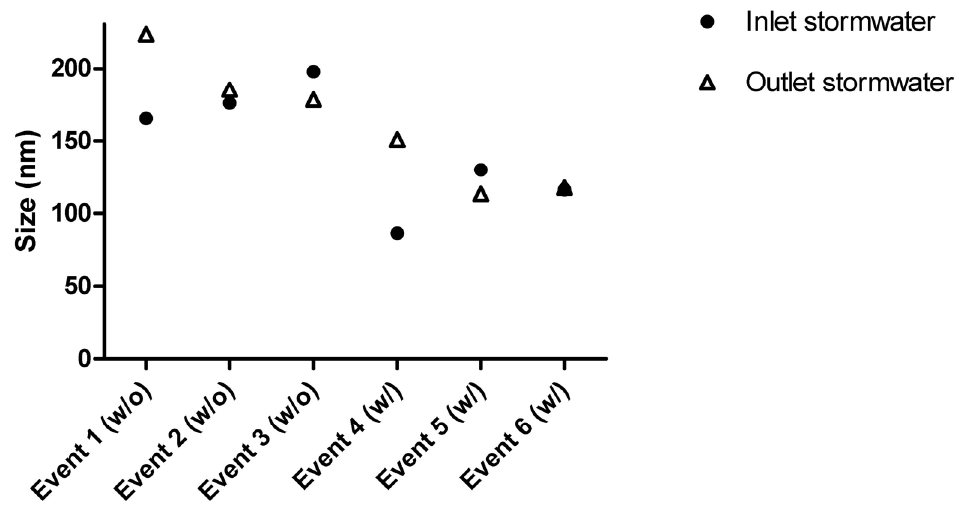
Figure 5. Nanosize particle sizes measured on ZetaSizer. w/o = without flocculant, w/ = with flocculant. Inlet = untreated runoff stormwater before entering the disc filter, outlet = treated water after passing through the 10 µm disc